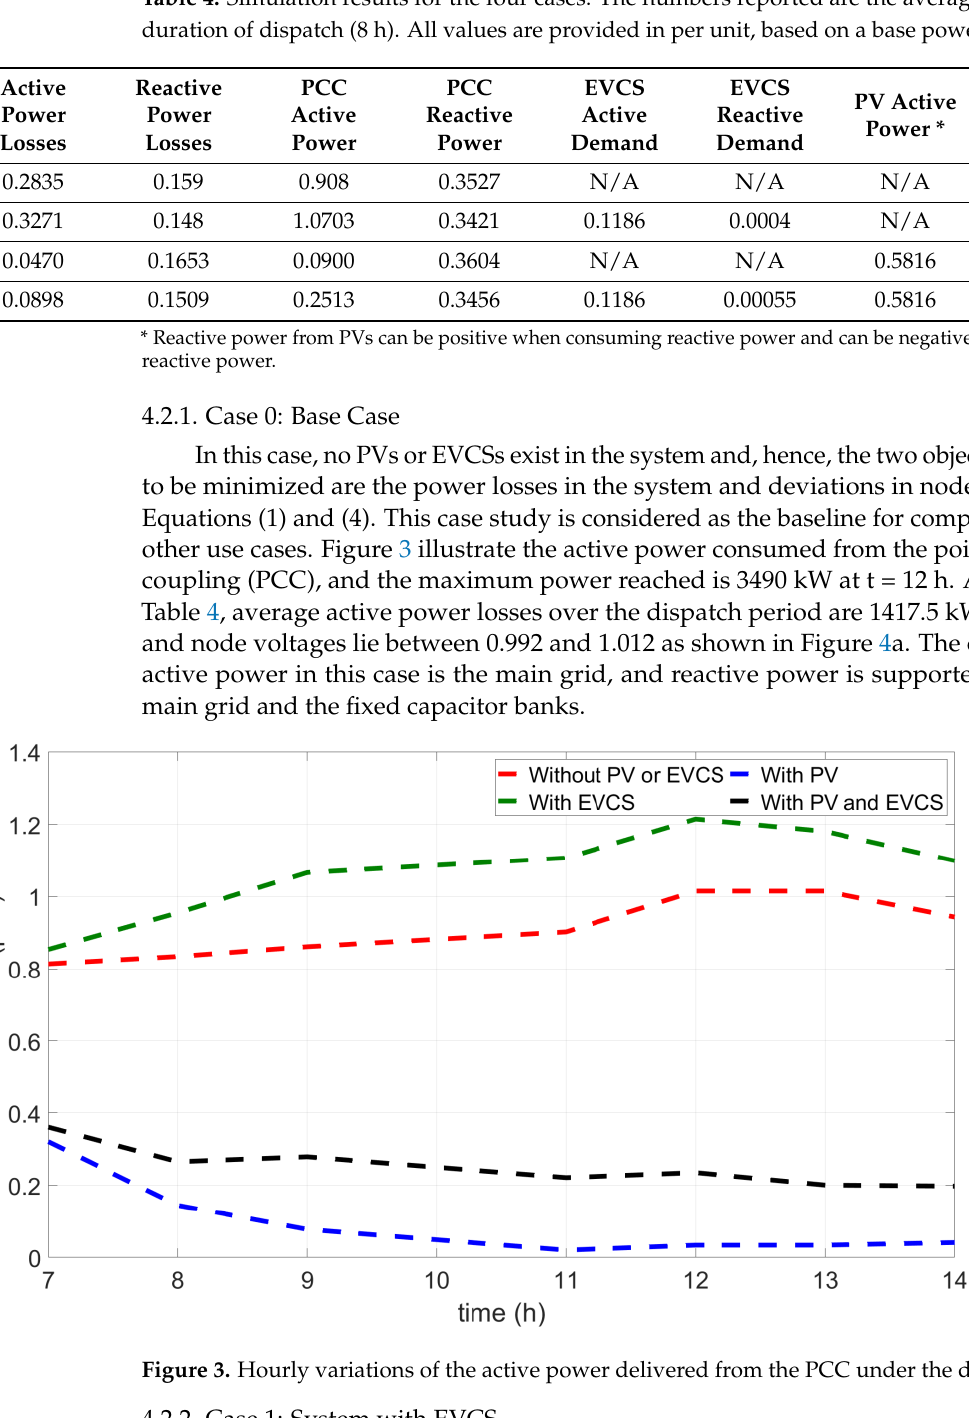
( d ) Figure 4. Comparison of node voltages during the course of dispatch: ( a ) Case 0; ( b ) Case 1; ( c ) Case 2; ( d ) Case 3.